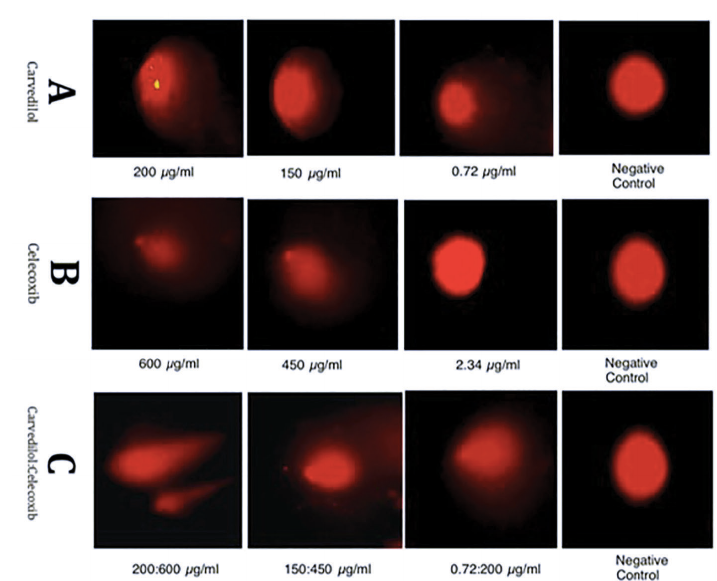
FIGURE 3 - Representative comets with increasing concentrations of three treatment groups. [A] shows the comets protrude by carvedilol 200 µg/mL, 150 µg/mL, 0.72 µg/mL and negative control (Class 0 Damage) [B] Shows the comets protrude by celecoxib 600 µg/mL, 450 µg/mL and 2.34 µg/mL and negative control [C] Shows the comets protrude by combine concentrations of carvedilol and celecoxib 200:600 µg/mL, 150:450 µg/mL, 0.72:2.34 µg/mL and negative control (Class 0 Damage) respectively. TABLE 3. Shows the mutagenic potential in terms of mean number of revertant colonies/plate, standard deviation (SD) and mutagenic index (M.I) recorded against salmonella typh i TA-98 and TA-100, in the presence (+S9) and absence (-S9) of metabolic activation